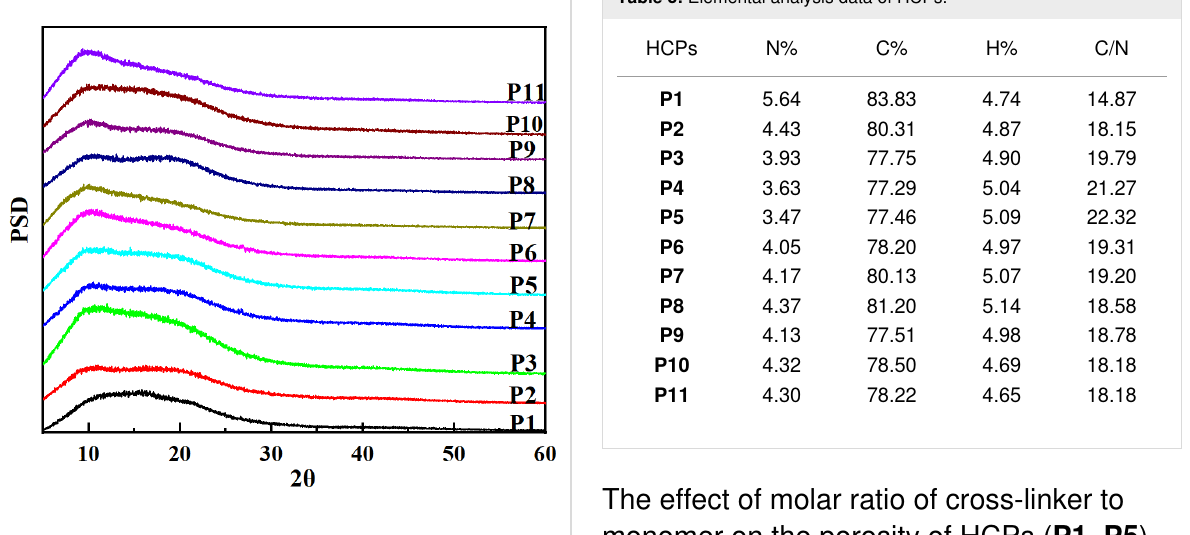
Table 3: Elemental analysis data of